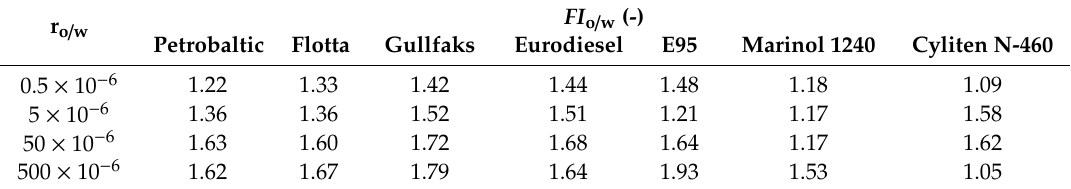
Table 3. Fluorometric index ( FI o / w ) calculated by Formula (2) for the seawater contaminated with individual oils on 15 March 2019.